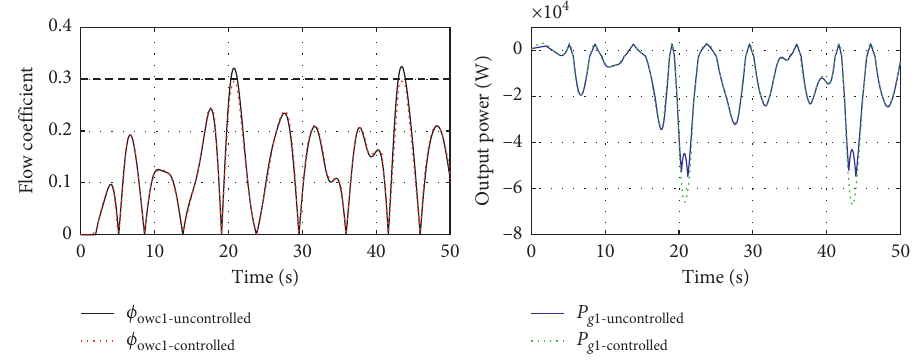
Figure 11: Flow coefficient and output power for OWC-1 with SW